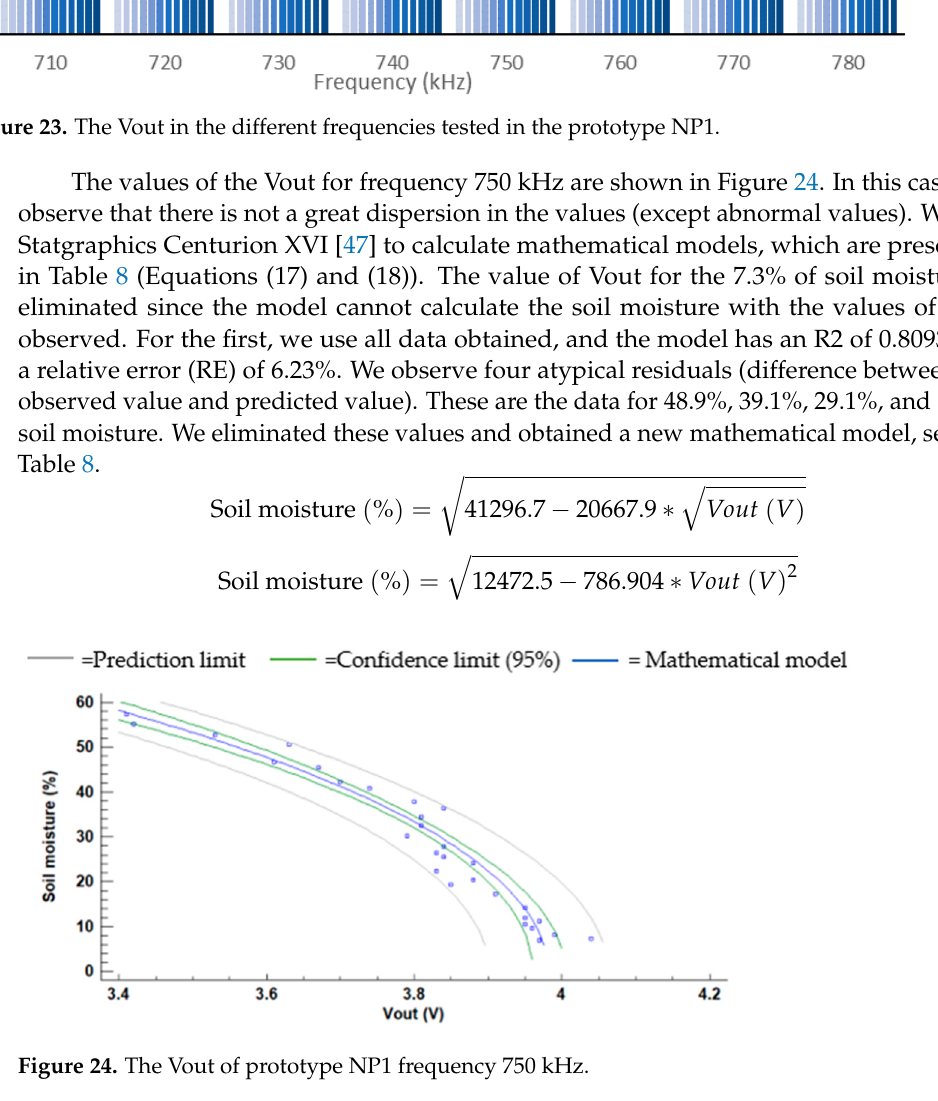
Figure 24. The Vout of prototype NP1 frequency 750 kHz. Table 8. Mathematical models to prototype NP1 frequency 750